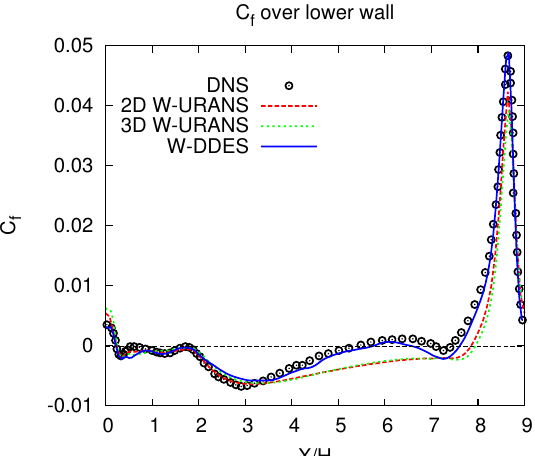
Figure 12. WA-DDES of periodic-hill channel: mean skin friction coefficient on the lower wall, compared to reference DNS